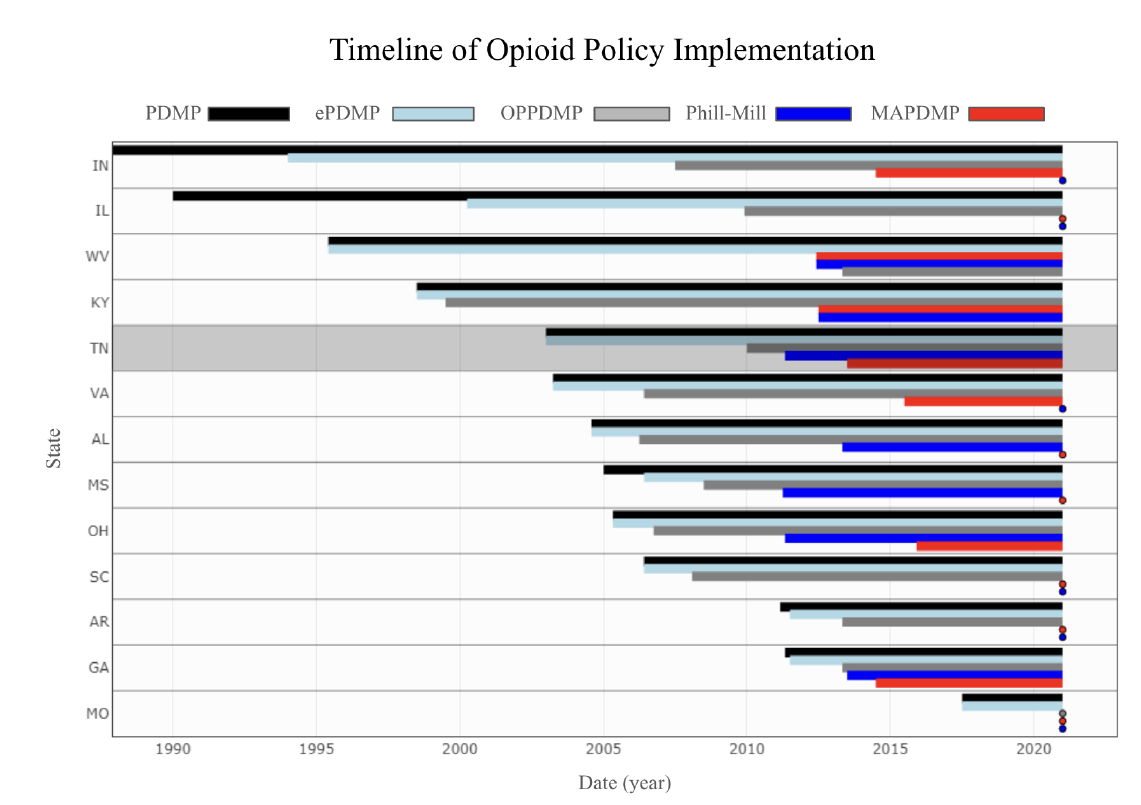
Figure 2. Policy Timeline; data on the policy implementation is provided by the RAND